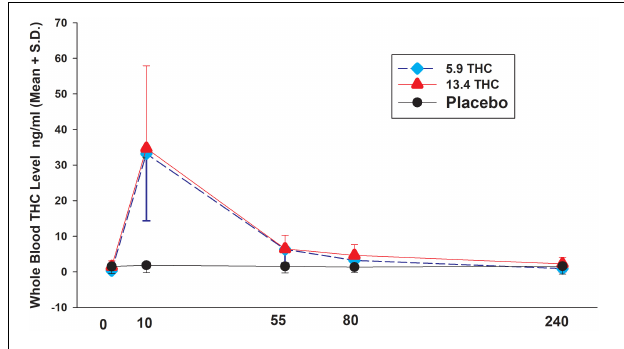
FIGURE 1 | THC levels in three treatment groups. Time after smoking